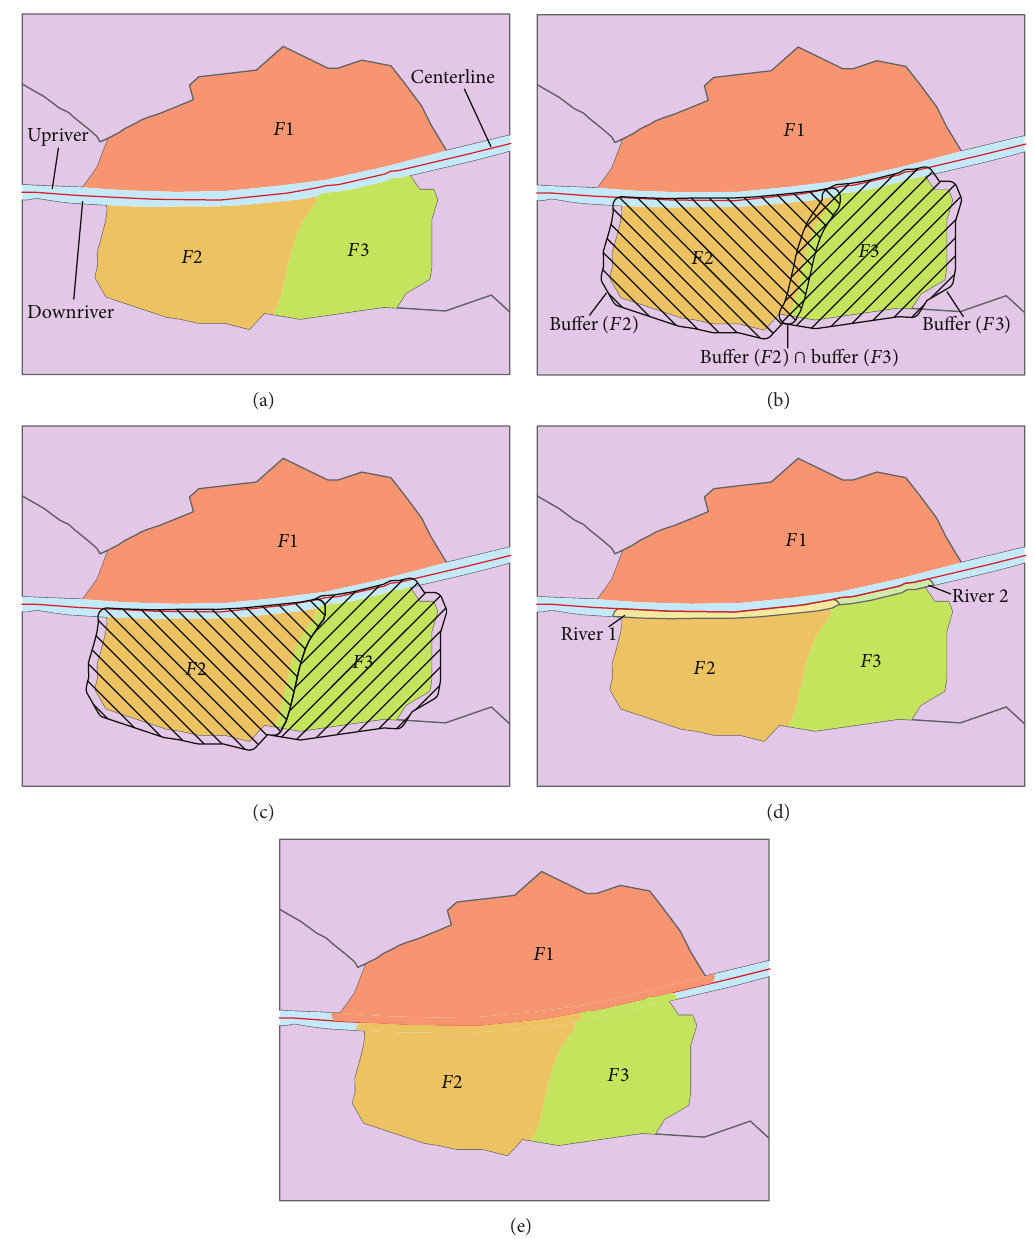
Figure 5: Process of handling strip